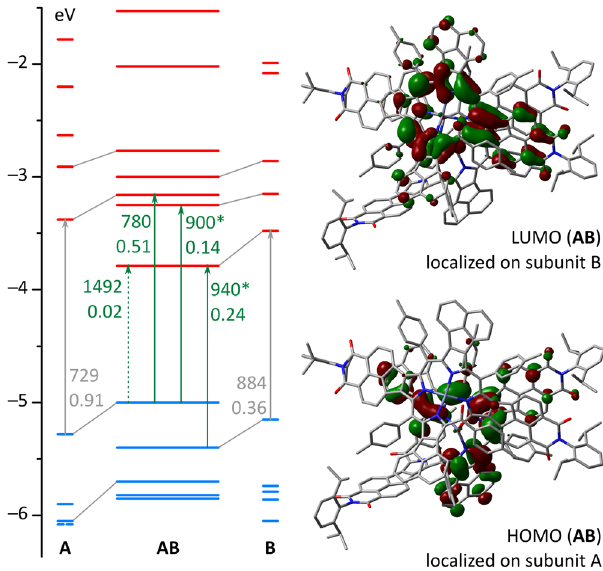
Fig. 5 Molecular orbitals of 2 ( = AB) and its constituent subunits A and B. (GD3BJ-B3LYP/6 – 31G(d,p)). Arrows and adjacent labels correspond to key electronic transitions, their wavelengths (nm), and oscillator strengths. Transitions marked with * contain contributions of other excitations (see